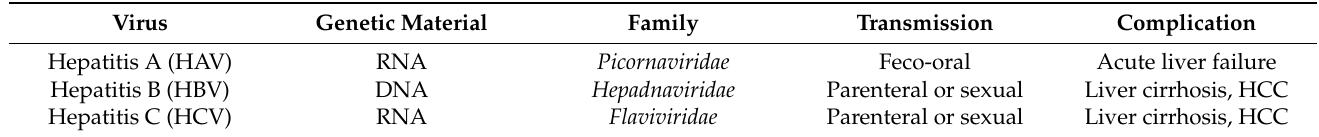
Table 1. Hepatotropic